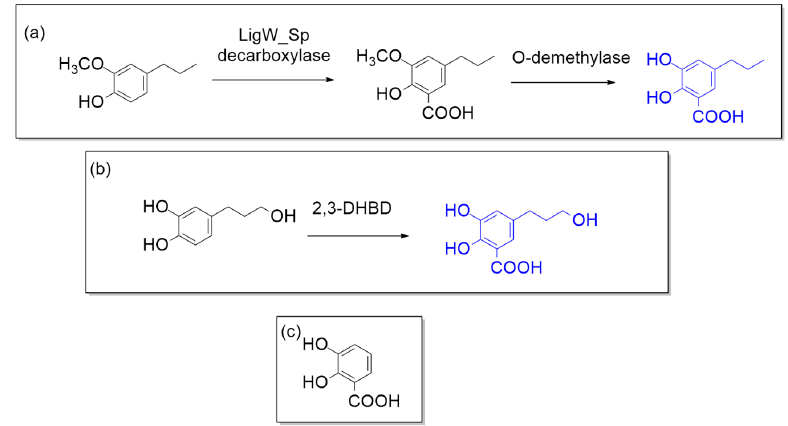
Figure 26. Possible role of the decarboxylase enzyme in the functionalisation of guaiacol- and catechol-derivatives to produce valuable compounds. Compounds in blue color could be obtained by using the synthetic biology technology. ( a )carboxylation and O-demethylation of a using the synthetic biology technology. ( a ) carboxylation and O-demethylation of a guaiacol-derivative; guaiacol-derivative; ( b )carboxylation of a catechol derivative; ( c )2,3-dihydroxybenzoic acid. ( b ) carboxylation of a catechol derivative; ( c ) 2,3-dihydroxybenzoic